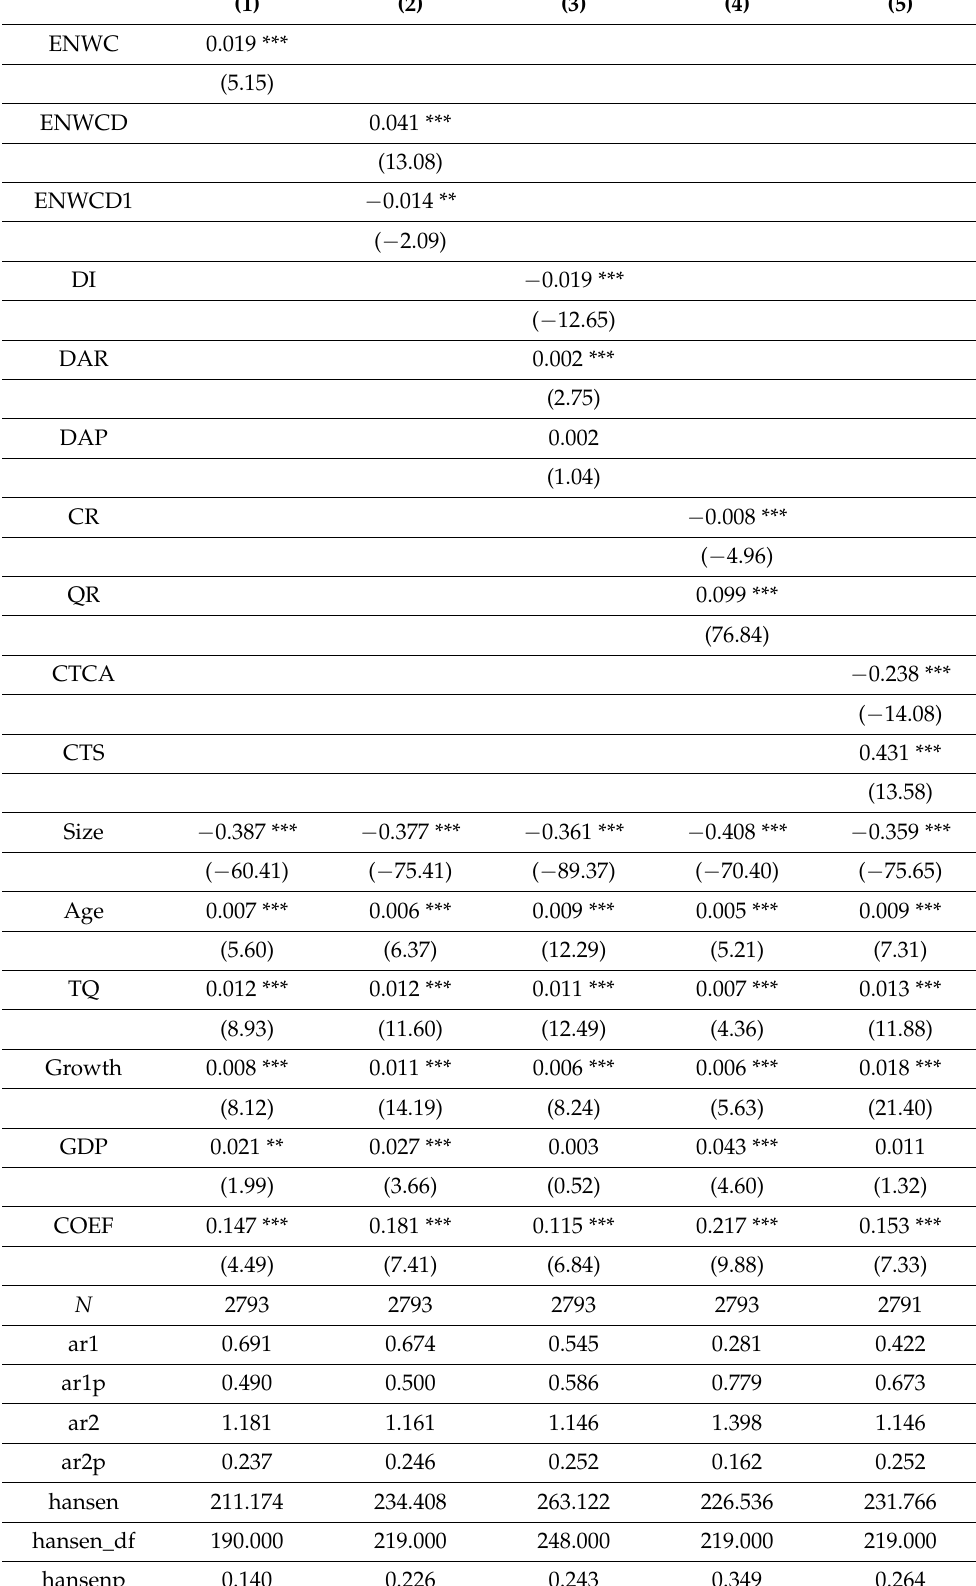
Table 6. GMM regression models. NOVOI is the dependent